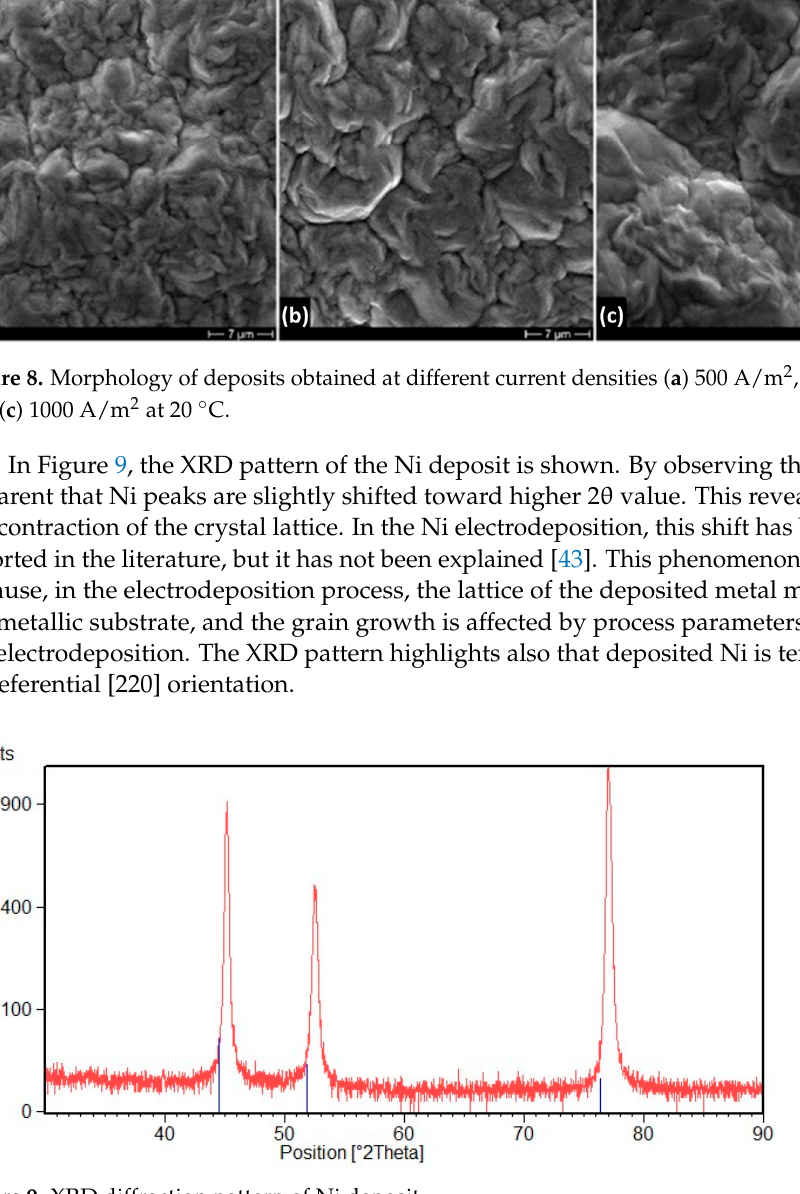
Figure 10. XRD di ff raction pa tt ern of Ni deposit after heat treatment at 170 °C.